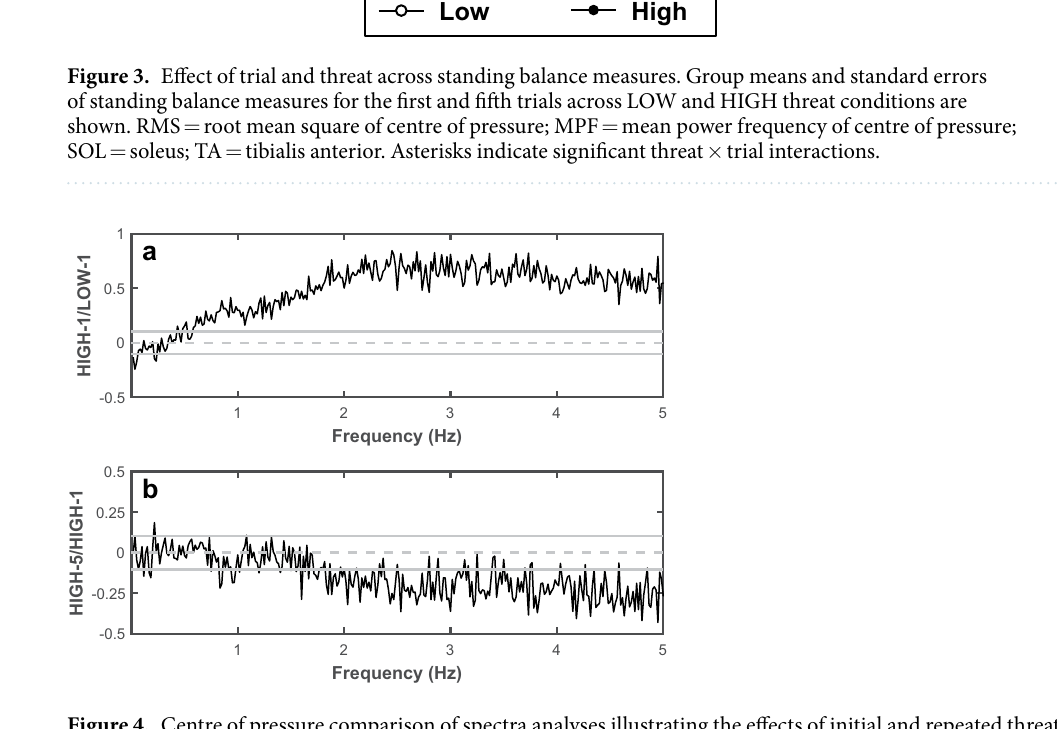
Figure 4. Centre of pressure comparison of spectra analyses illustrating the effects of initial and repeated threat exposure. Data shown reflect the log ratio of COP power spectral density between the first HIGH and LOW trial ( a ) and fifth and first HIGH trial ( b ) across frequencies (resolution 0.0167 Hz). Horizontal grey lines reflect 95% confidence